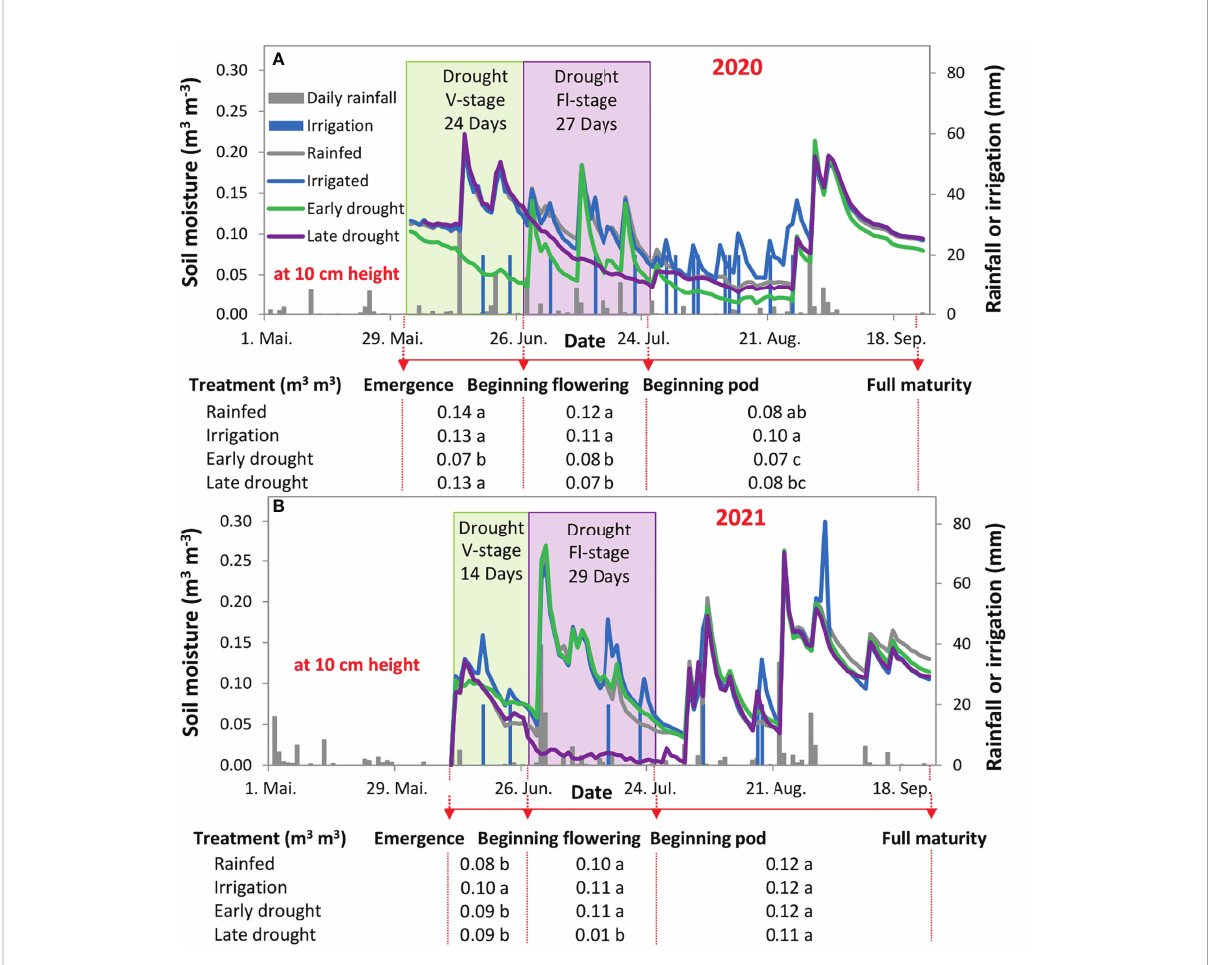
FIGURE 2 Soil moisture at 10 cm height (left axis; A, B ) and daily rainfall or irrigation (right axis; both panels) from the beginning of May till the end of September in 2020 (A) and 2021 (B) . The green shaded area indicates the duration of using a shelter above the plants at the vegetative stage (V- stage) and the violet shaded area indicates the duration of using a shelter above the plants at the fl owering stage (Fl-stage). The Meteorological elements and bioclimatic index for the soybean development stages, in both years, are in the tables below each fi